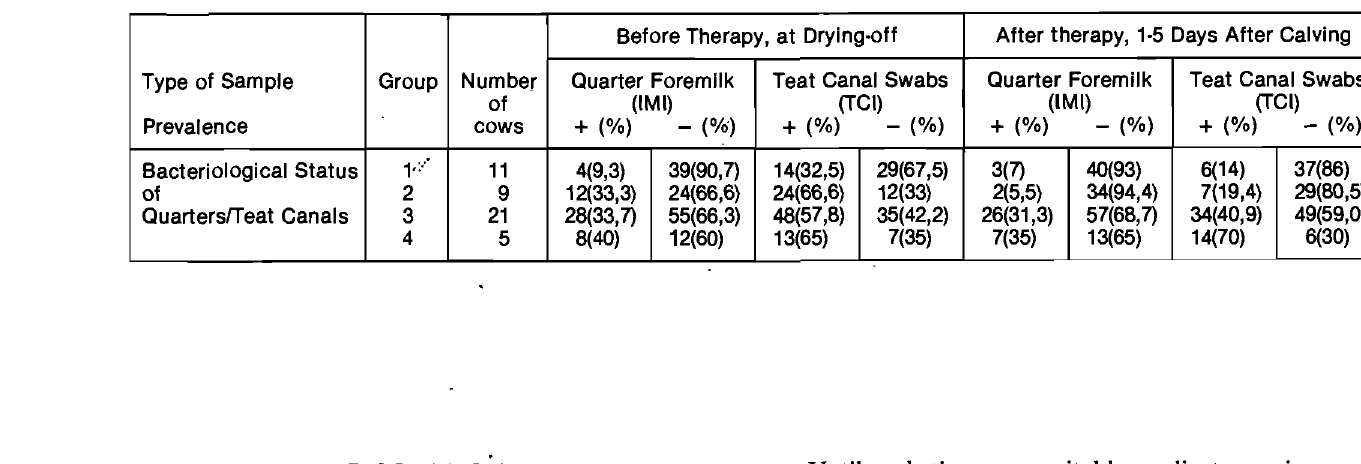
Table 5: Summary of bacteriological data from intramammary (IMI) and teat canal infections (Tel) of experimental